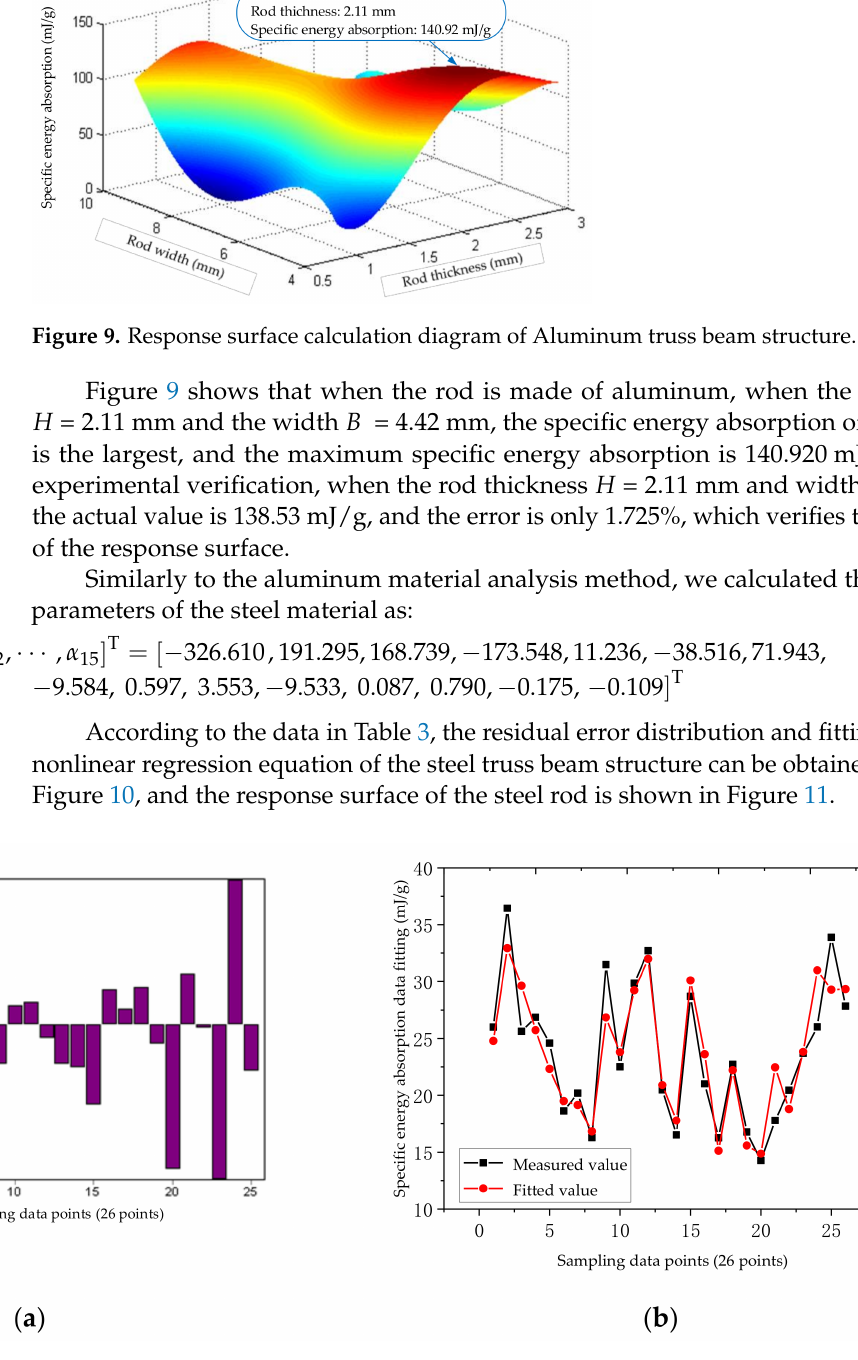
Figure 10. Non-linear regression statistical parameters of the steel truss beam structure: ( a ) Residual error distribution; ( b ) Fitting